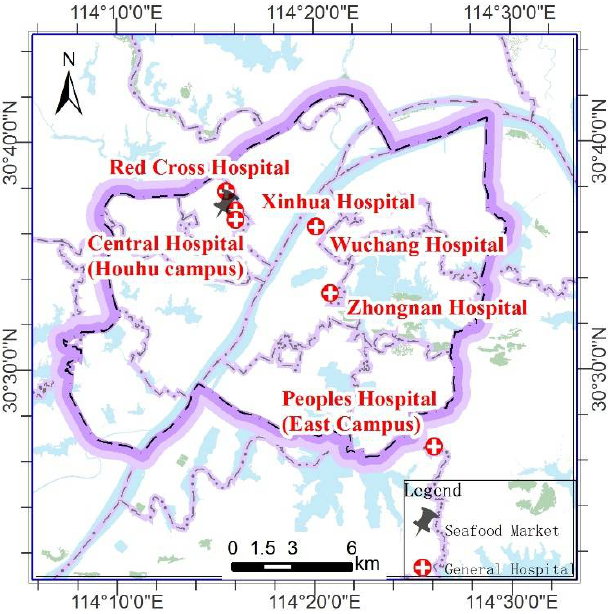
Figure 3. The spatial distribution of general hospitals in Wuhan.